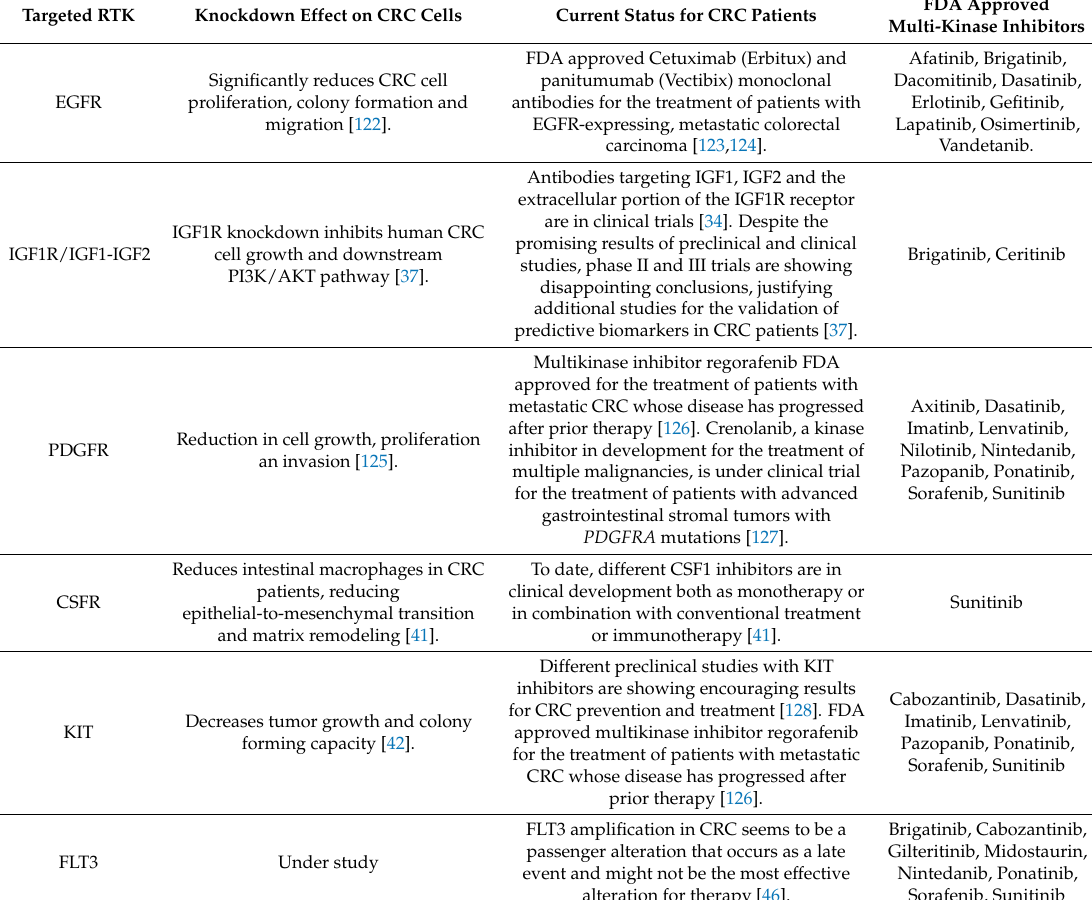
Table 4. Receptor Kinase Inhibition in